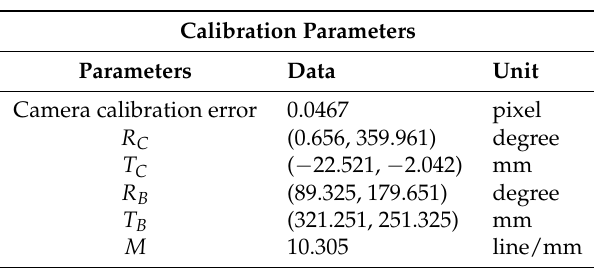
Figure 10. Camera-conveyer-robot hybrid modular calibration. Table 3. Calibration results.